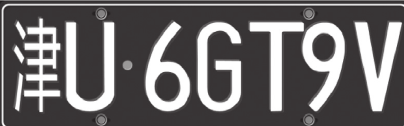
Figure 8: Graying of license